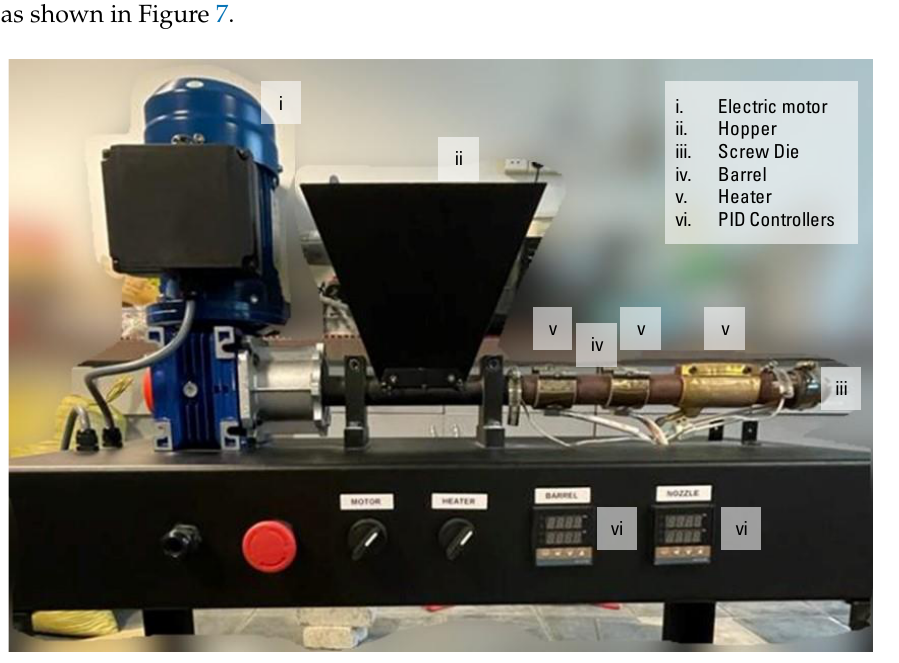
Figure 8. Diagram of single-flighted, stepped compression screw design and the mechanism zone. When the plastic melt reached the screw’s end, it was thoroughly mixed and pushed through the die. The extrudate was pulled and cooled at room temperature for 2 h after exiting the extruder. During the extrusion process, the extrudate composites flow out con- tinuously, irrespective of the amount of pre-mixed rPET flakes and fly ash added into the hopper. However, the process will still result in the degradation of the composite material Metering